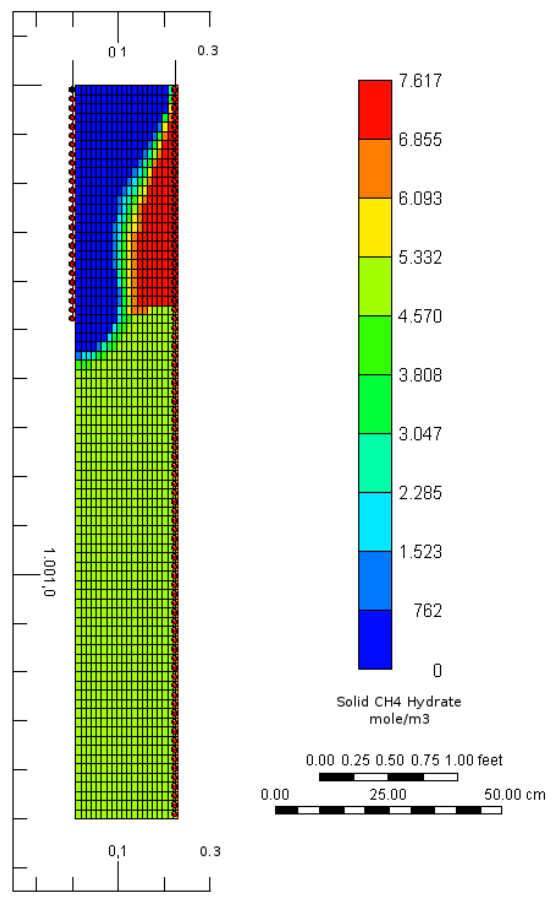
Figure 4. Distribution of methane hydrates inside pressure vessel after 24 hours of heating at 200 W. The figure shows a cross-section of the radially symmetrical model from the central axis (left) to the wall (right) of the pressure